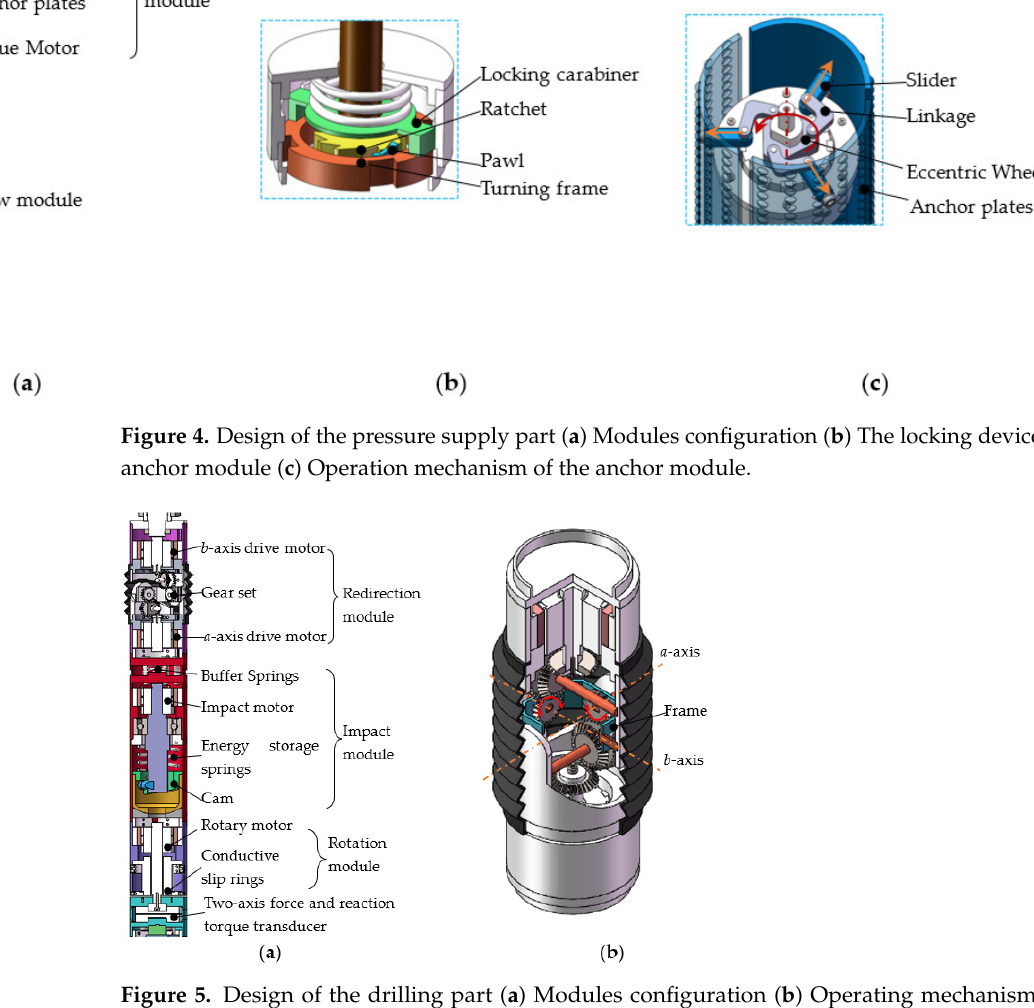
Figure 4. Design of the pressure supply part ( a ) Modules configuration ( b ) The locking device of the anchor module ( c ) Operation mechanism of the anchor module.